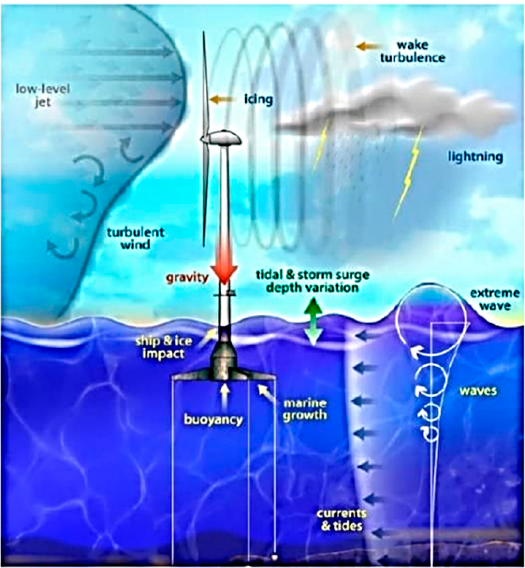
Figure 4. Types of wind and wave loadings on an FOWT